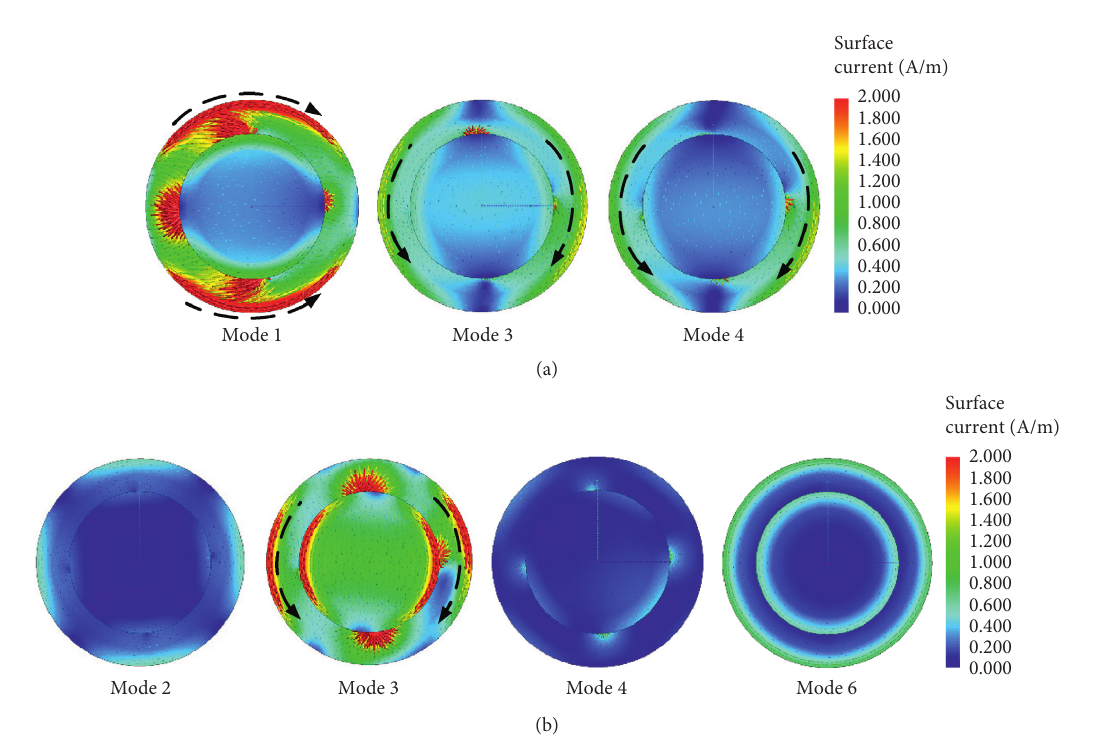
Figure 13: Modal current distribution of the antenna with four probes at (a) 1.72GHz and (b) 1.96